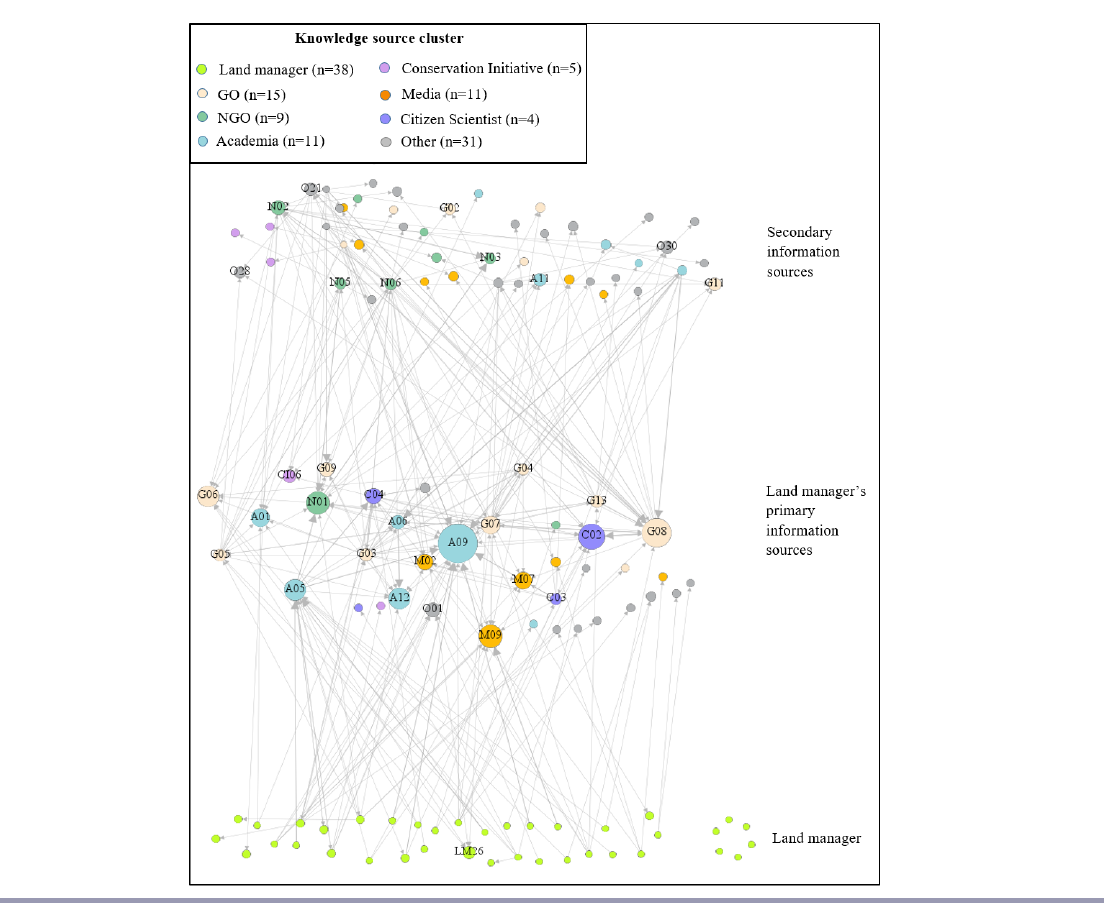
Fig. 2. Network diagram of the information network for renosterveld conservation. The color of a node represents the knowledge source cluster the individual is associated with; GO = governmental organization, NGO = nongovernmental organization. The size of the node indicates the in-degree centrality (number of links entering the node). Labels are shown for stakeholders with an in-degree ≥ 2. Arrows point to the information source that was named. Six landowners did not have any information source. A09 had the highest in-degree centrality ( N = 22), followed by GO08 ( N = 15).